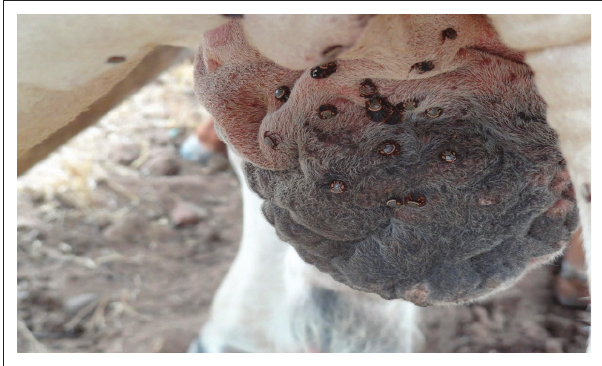
FIGURE 1: Adult long-mouthed ticks of the species Hyalomma rufipes and Amblyomma hebraeum attached to the